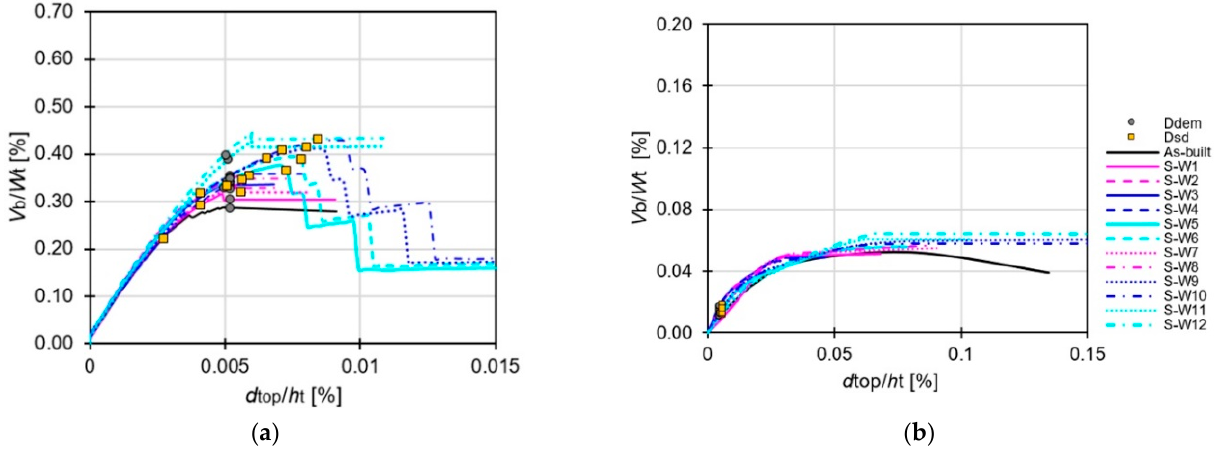
Figure 11. Normalised SDOF-NLS curves considering the S-RP1 solutions in the X- ( a ) and Y- ( b ) direction. ( b )